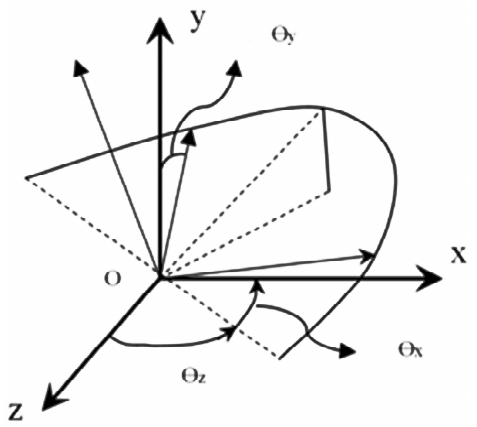
Figure 1. The Euler angles (X, Y, Z are the principal axes).